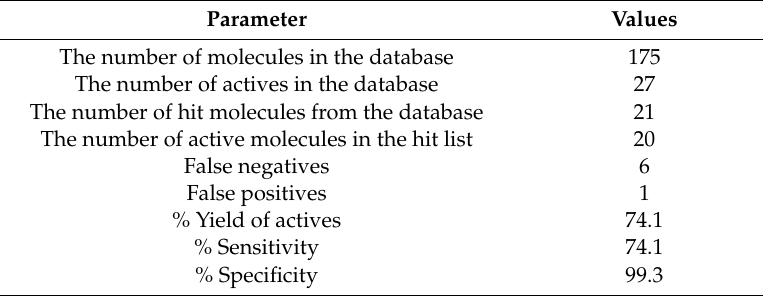
Table 2. Results of the decoy set.